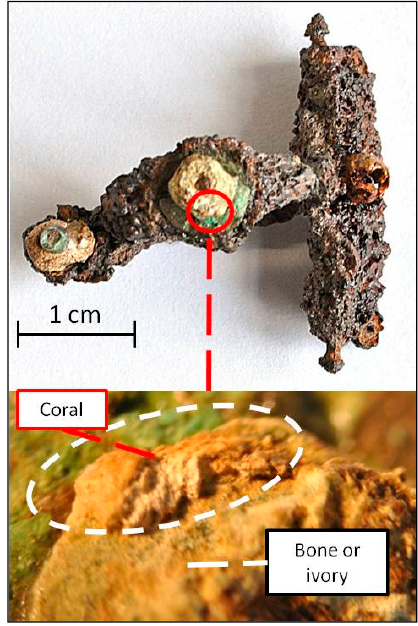
Figure 8. Small iron fibula from Ilvesheim “Weingärten”. The picture below shows the detail of the bead on the bow with the microscopic coral piece adhering to a base made of apatite-containing material.